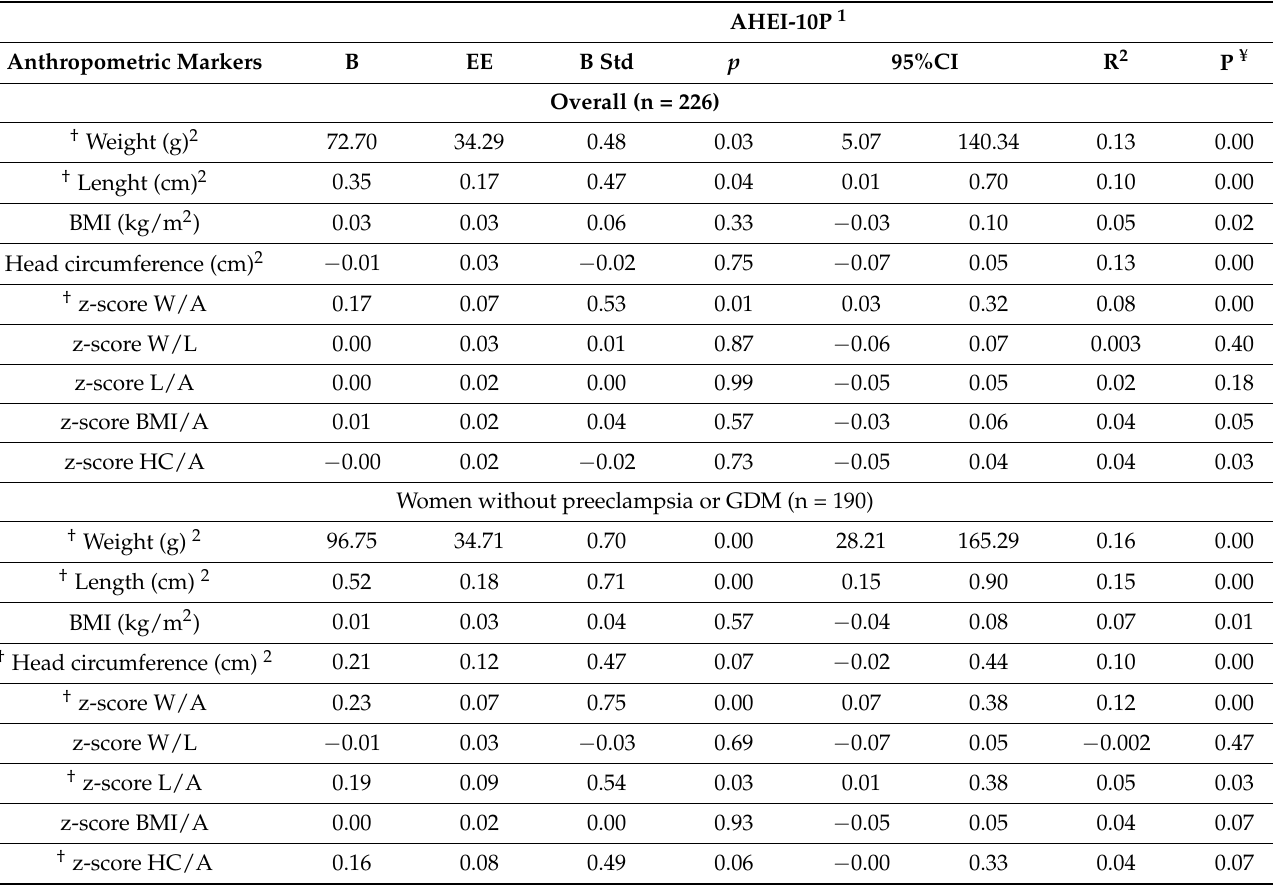
Table 5. Effect of diet quality on anthropometric markers.